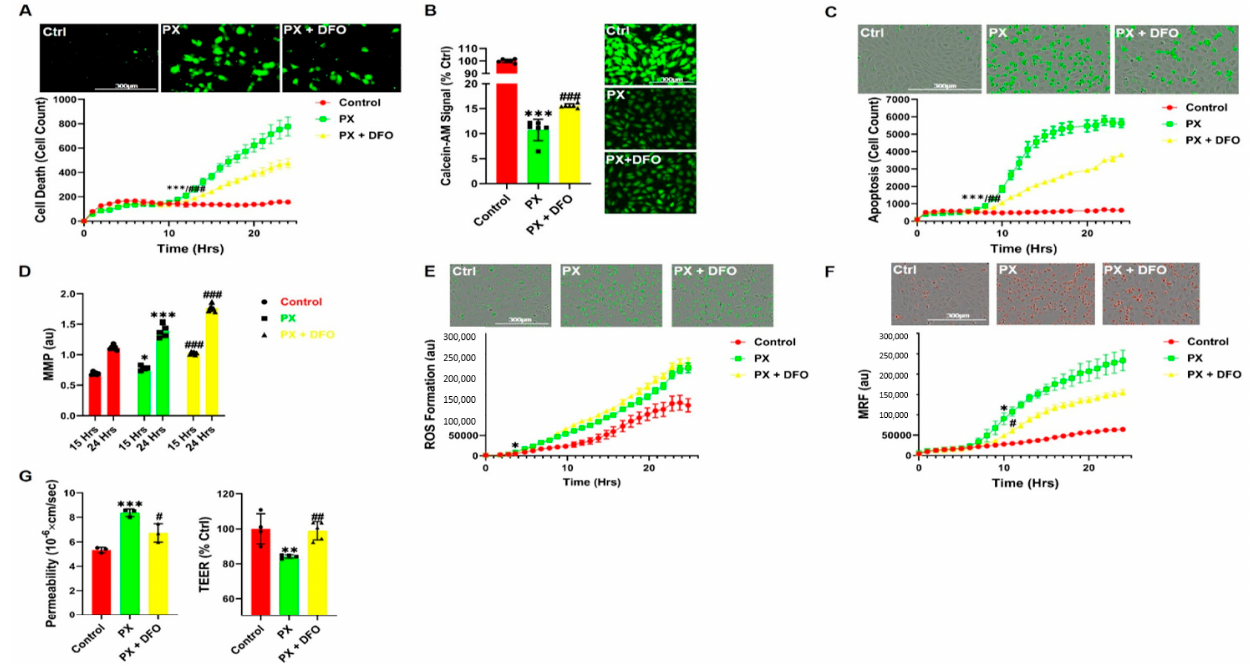
Figure 3. DFO diminishes cell toxicity and rescues barrier functions. ( A ) Live cell imaging of cell death was examined by cytotoxicity 24 h post 400 µM PX treatment on a BLEC monolayer. DFO was added at 50 µg/mL. Ctrl are cells cultured cytotoxicity 24 h post 400 µ M PX treatment on a BLEC monolayer. DFO was added at 50 µ g/mL. Ctrl are cells